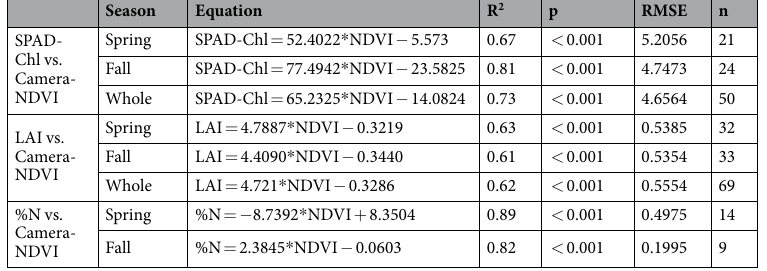
Table 1. Linear regressions equations between camera -NDVI and plant physiological properties.